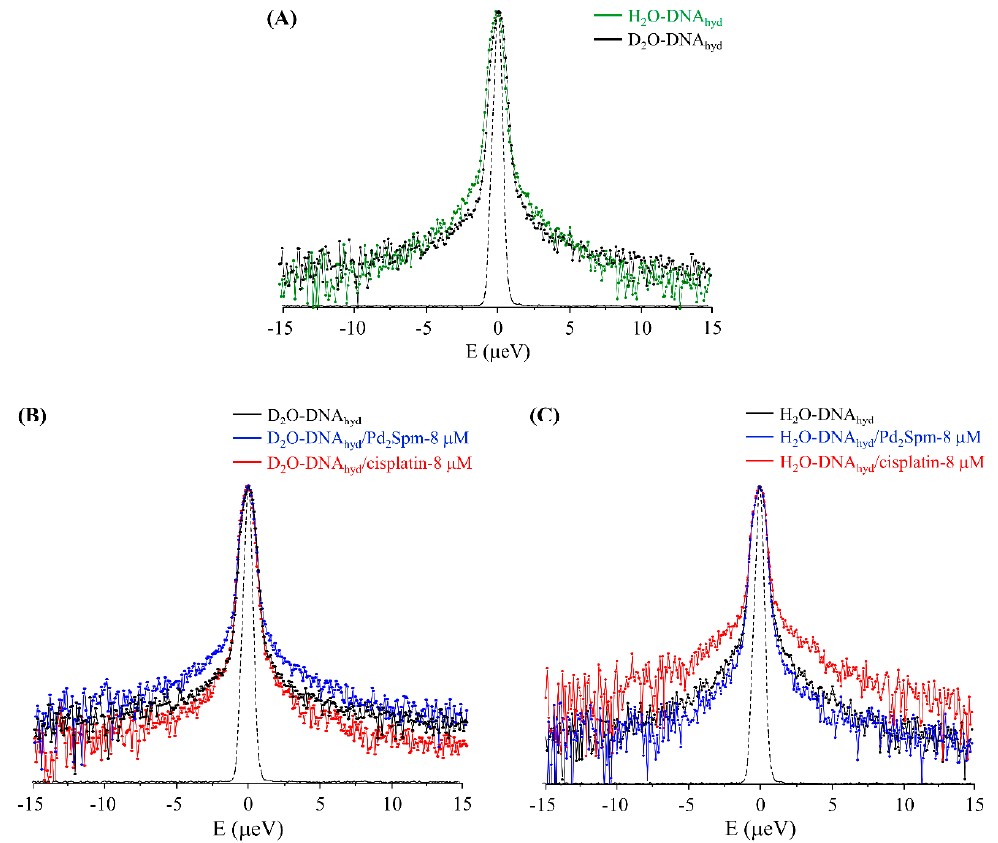
Figure 6. QENS profiles (298 K, averaged over the entire Q range, logarithmic scale) for: ( A ) H 2 O-DNA hyd vs D 2 O-DNA hyd ; ( B , C ) untreated and drug-exposed (8 μ M) D 2 O-DNA hyd and H 2 O-DNA hyd , respectively.The spectra were normalised to maximum peak intensity. The black dashed line represents the instrument resolution.